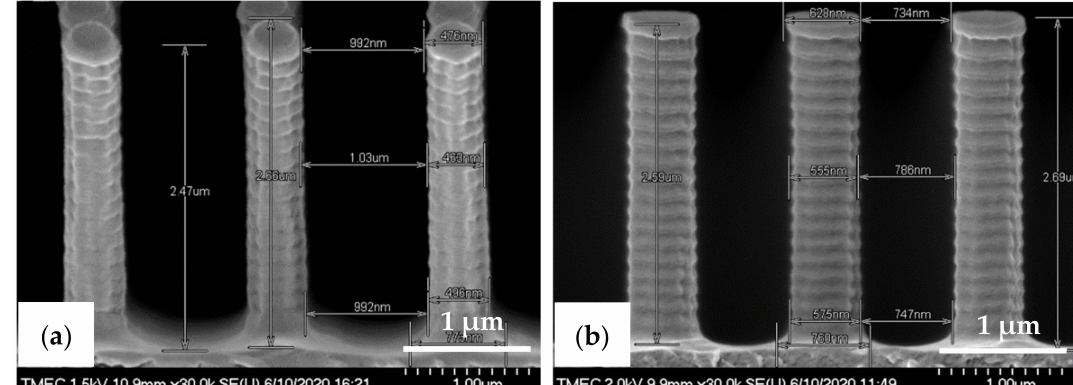
Figure 12. Cross-sectional view SEM images with corresponding measured dimensions of the pillar micro-structure (designed pattern size: diameter: 0.5 µ m, height: 2.5 µ m) replicated by R2P NIL process ( a ) imprint on PC foil with resin A (PIL-A) and ( b ) imprint on PC foil with resin B